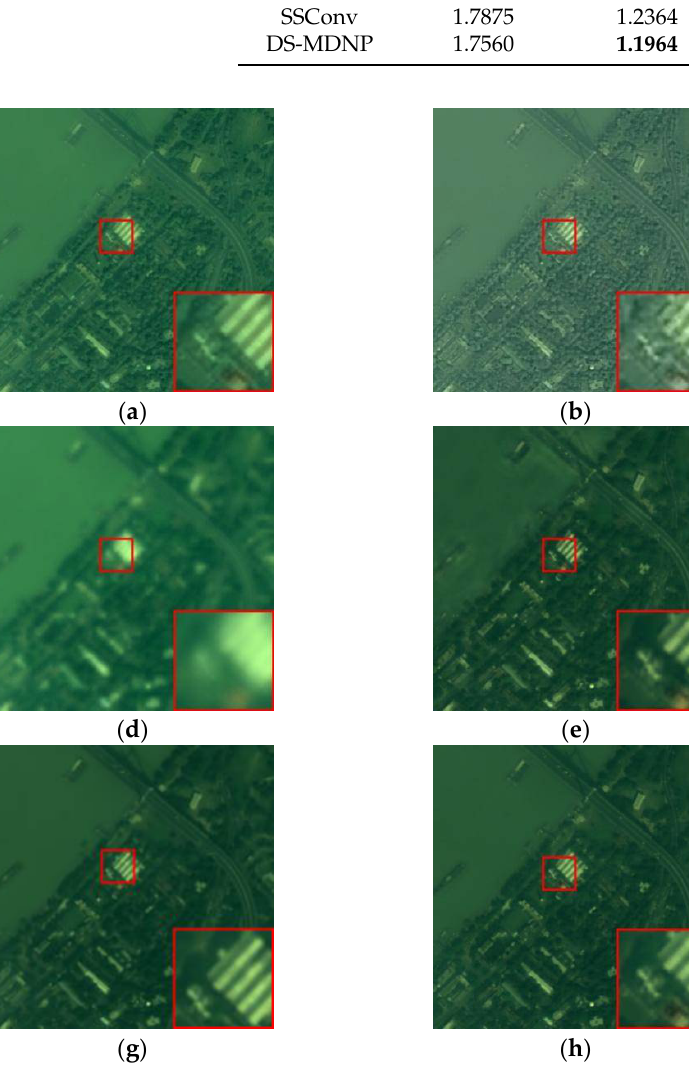
Figure 8. Fused images of QuickBird where ( a ) IHS, ( b ) Wavelet, ( c ) HPF, ( d ) PRACS, ( e ) PNN, ( f ) Fusion-Net, ( g ) SSConv, ( h ) DS-MDNP, and ( i ) GT.